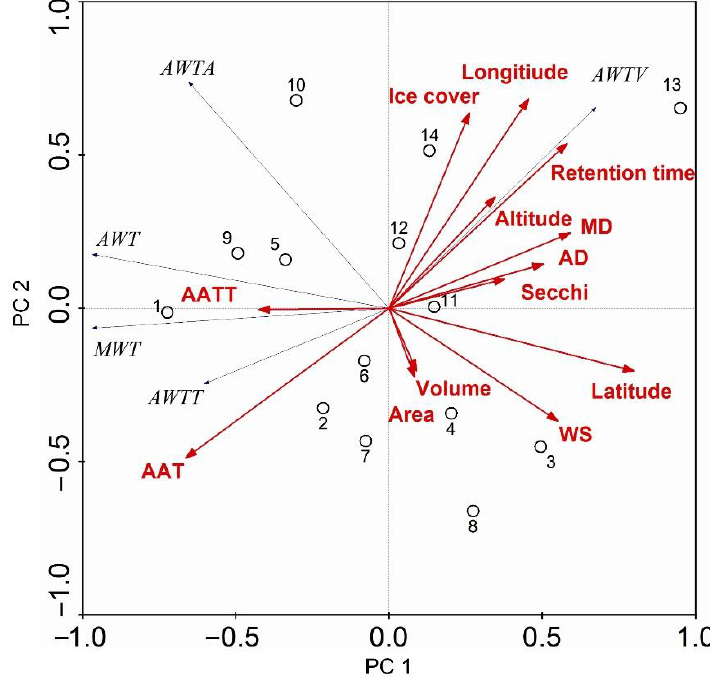
Figure 7. Results of principal component analysis (PCA) between thermal parameters of waters in the lakes and climatic and non-climatic parameters.